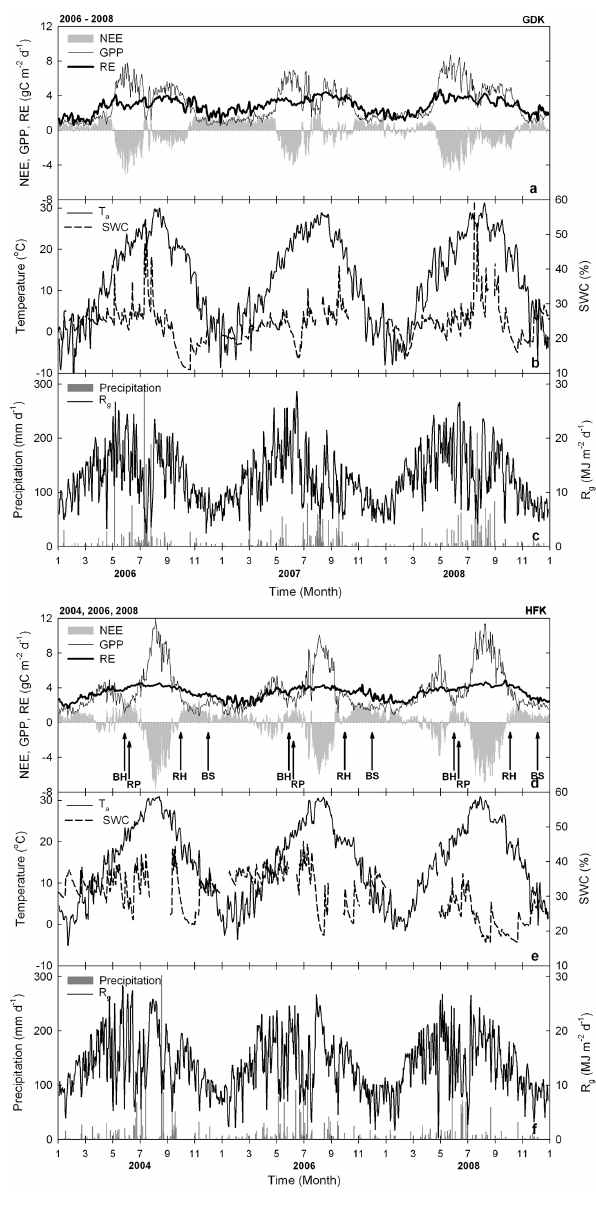
Fig. 5. Seasonal variation of Net Ecosystem Exchange (NEE), Gross Primary Productivity (GPP), Ecosystem Respiration (RE), air temperature ( T a ), Soil Water Content (SWC), precipitation, and so- lar radiation ( R g ) at the GDK site (2006 to 2008) and the HFK site (2004, 2006, and 2008). In the HFK site, the arrows represent the main management interventions: BS: Barely Sowing, BH: Barely Harvest, RP: Rice Planting, RH: Rice Harvest. Note that the man- agement interventions occurred over several consecutive days not at an exact point where the arrows